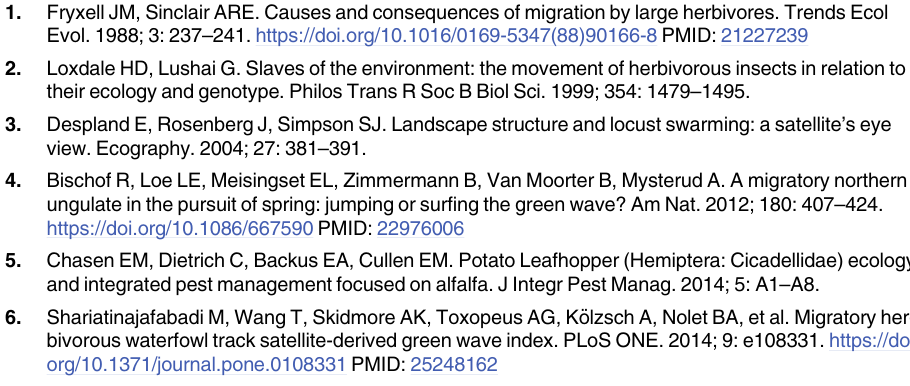
S4 Table. Pairwise F of potato psyllids from nightshades at the Moses Lake site. ST S5 Table. Pairwise F of potato psyllids from potatoes at Othello. ST S6 Table. Median pairwise genetic distance and F among groups of psyllids designated ST following ADMIXTURE K =